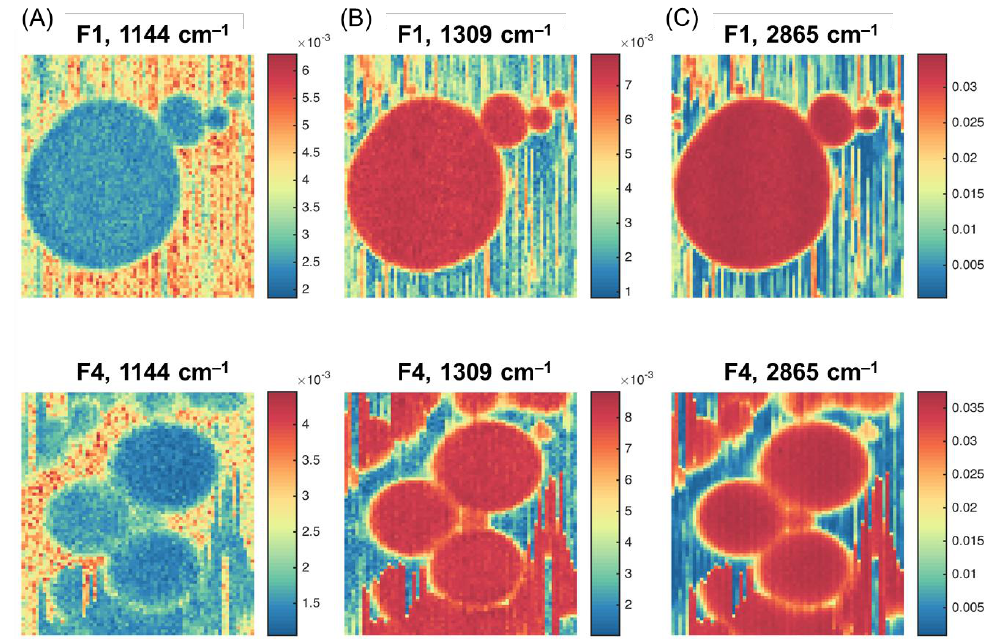
Figure 3. Hyperspectral images for Samples F1 and F4 at the selected wavelengths: ( A ) 1144 cm −1 ; ( B ) 1309 cm −1 ; ( C ) 2856 cm −1 . ( B ) 1309 cm − 1 ; ( C ) 2856 cm − 1